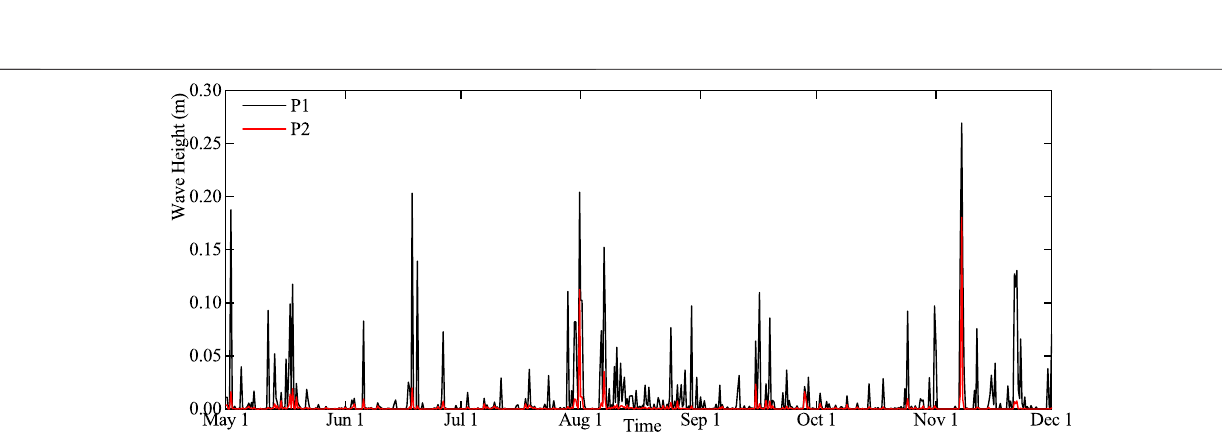
Frontiers in Environmental Science |